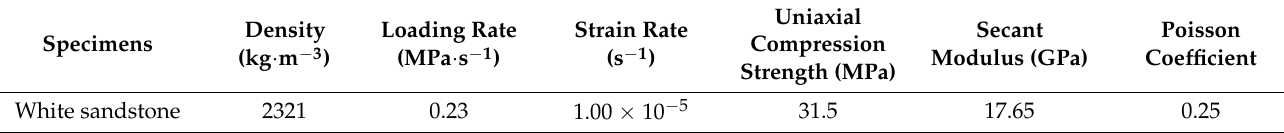
Table 2. Physico-mechanical parameters of white sandstone